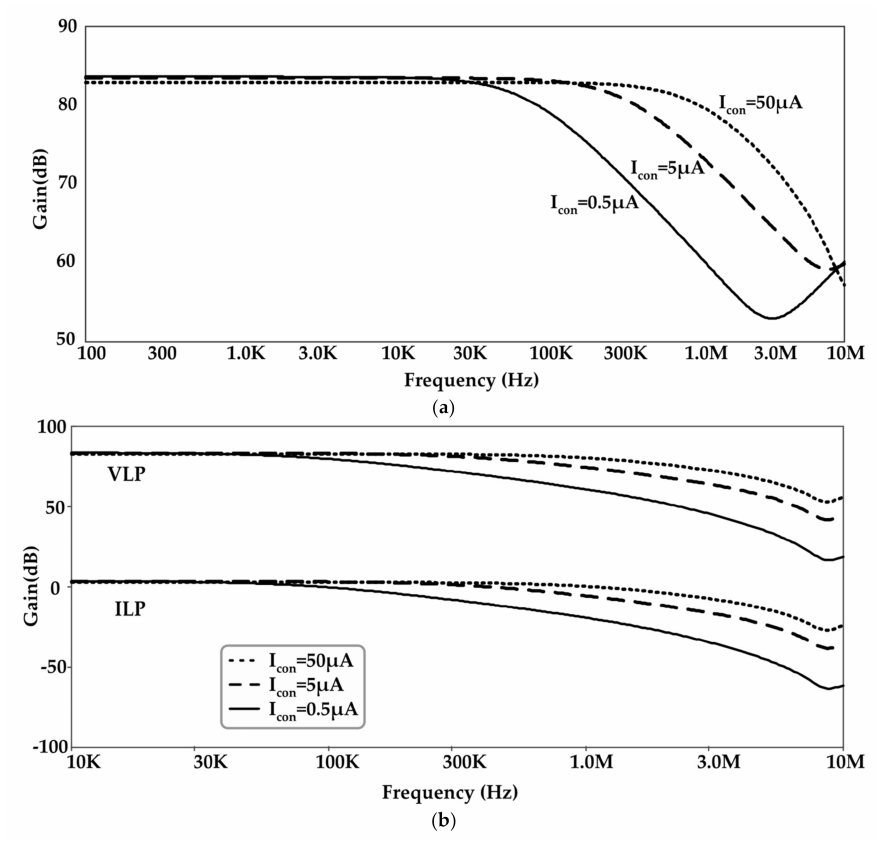
Figure 8. Frequency performance of LP output for different values of I con for the filters represented in Figures 2a and 3b.